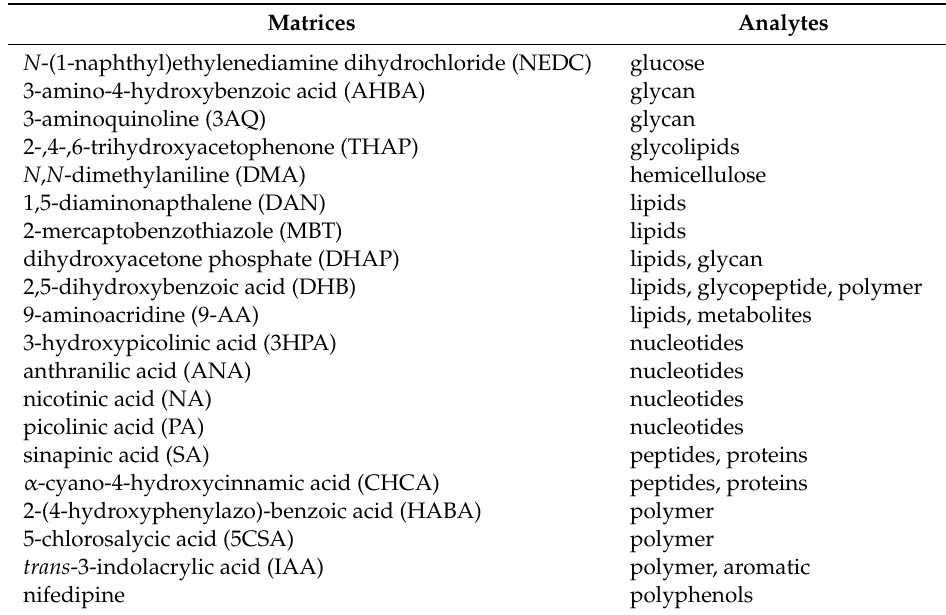
Table 2. Examples of matrix used in